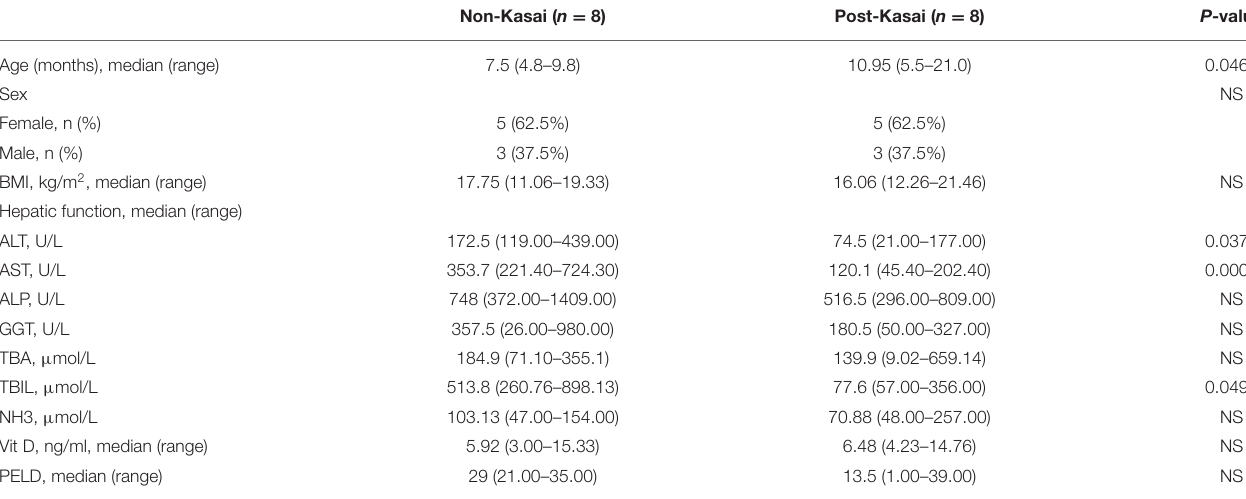
TABLE 1 | Clinical characteristics of the patients.